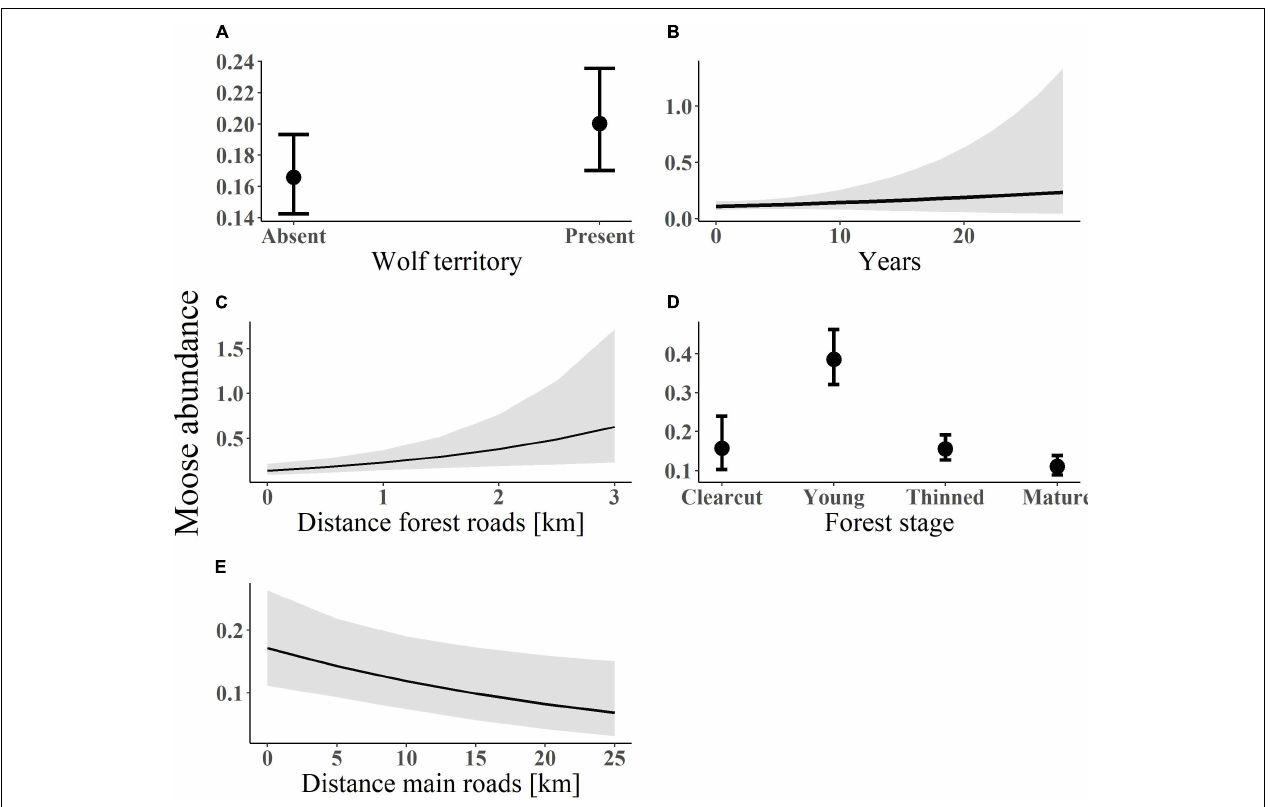
FIGURE 2 | Predicted values of moose abundance (measured as the number of pellet counts) in relation to (A) wolf presence; (B) years since wolf territory establishment; (C) distance from forest roads; (D) forest age stage; and (E) distance from main roads. Data on moose pellet counts were recorded within south-central Sweden between 2003 and 2016. The lines (in plot B–E ) represent the fitted values with associated standard errors from the model-averaged estimates. Plot a and d show the coefficients and confidence intervals of the predicted values of moose abundance in relation to presence/absence of a wolf territory (A) and across four forest age stages (D) .